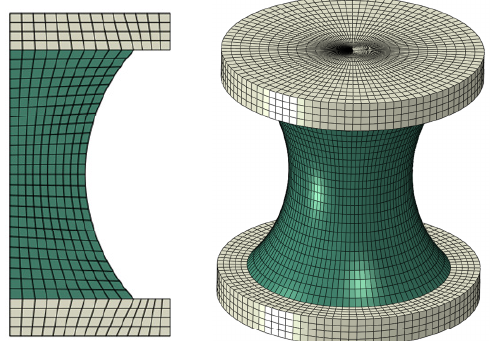
Figure 4. Axisymmetric geometric model of the hourglass rubber specimen (left: before rotation, right: after rotation).